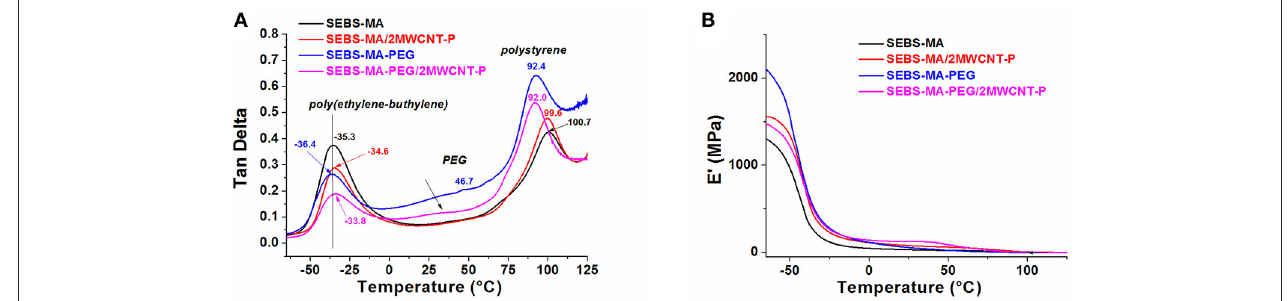
FIGURE 5 | (A) The tan delta curve and (B) Young’s modulus of the studied samples measured by DMA.